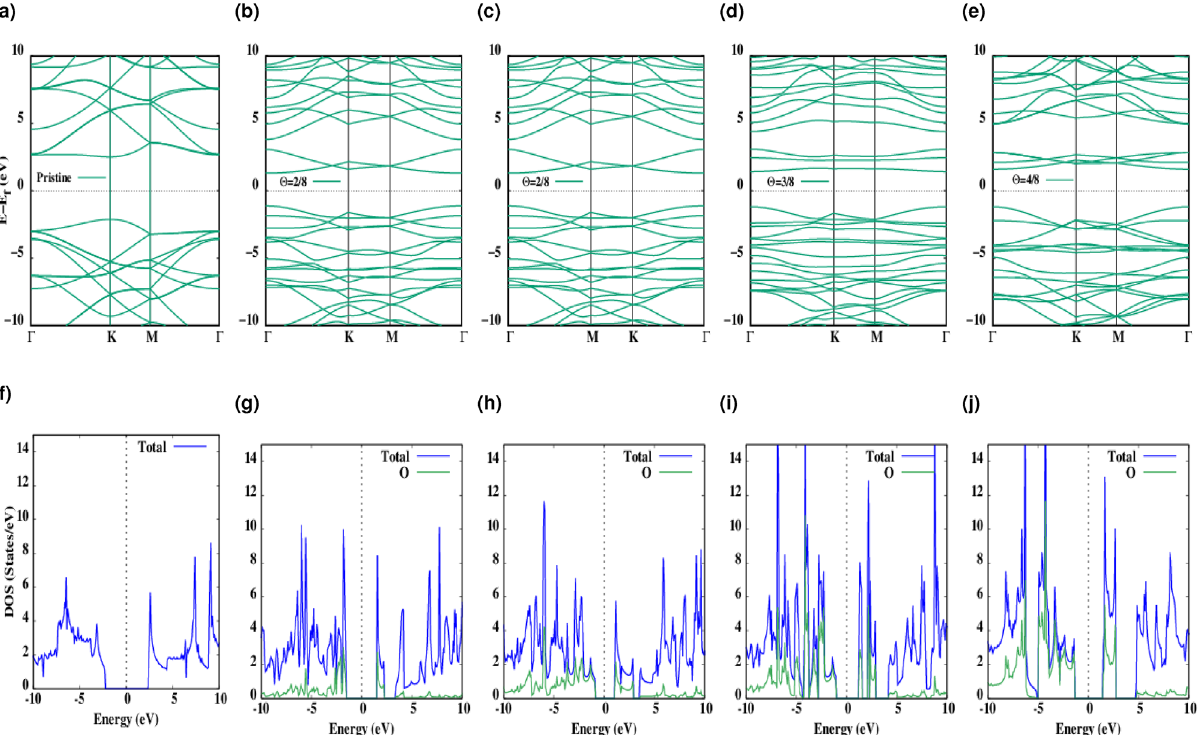
2 ) supercell. ( b – e ) The ×